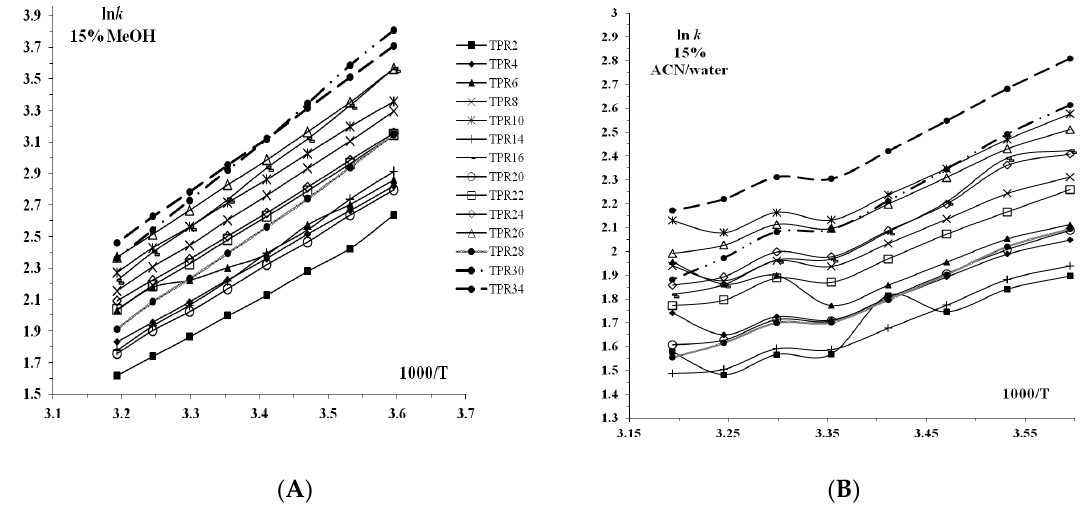
Figure 4. Van’t Hoff plots between the natural logarithms of the retention factors vs. 1000/T for the examined compounds. ( A ) 15% methanol as the mobile phase; ( B ) 15% acetonitrile as the mobile phase.